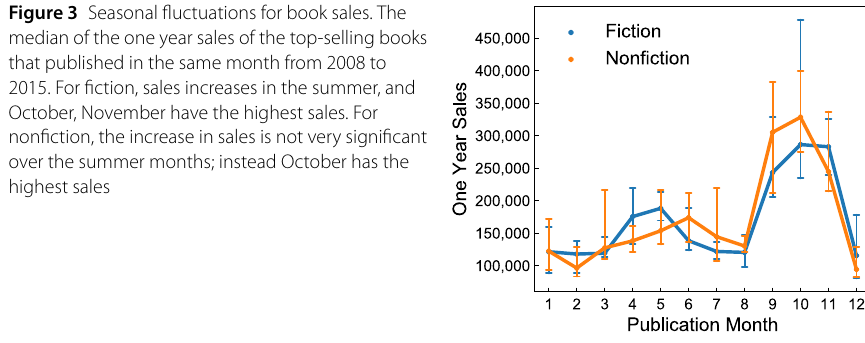
Figure 3 Seasonal fluctuations for book sales. The median of the one year sales of the top-selling books that published in the same month from 2008 to 2015. For fiction, sales increases in the summer, and October, November have the highest sales. For nonfiction, the increase in sales is not very significant over the summer months; instead October has the highest